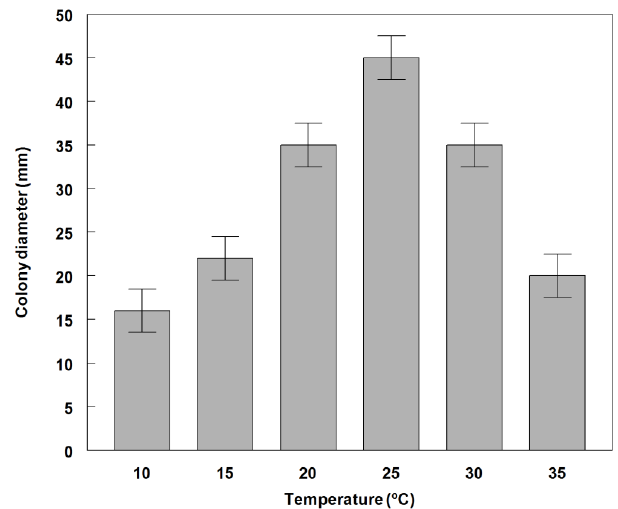
Figure 3. Effect of temperature on radial growth of P. commelinicola colonies on PDA, 7 days after inoculation and growth under alternating light/dark conditions (12 h light/dark at 28 °C). Error bars represent Fisher’s LSD ( p = 0.05).